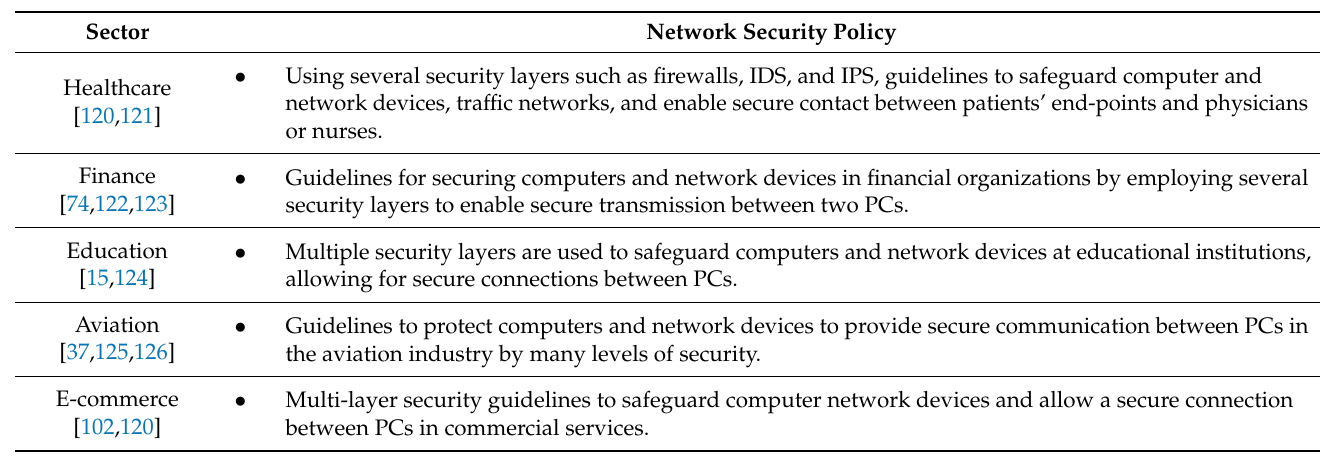
Table 7. Network security policy among different